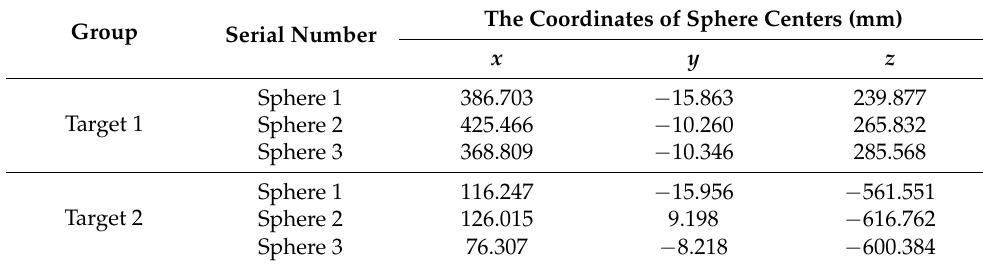
Table 5. Target ball center values for articulated arm calibration. Group